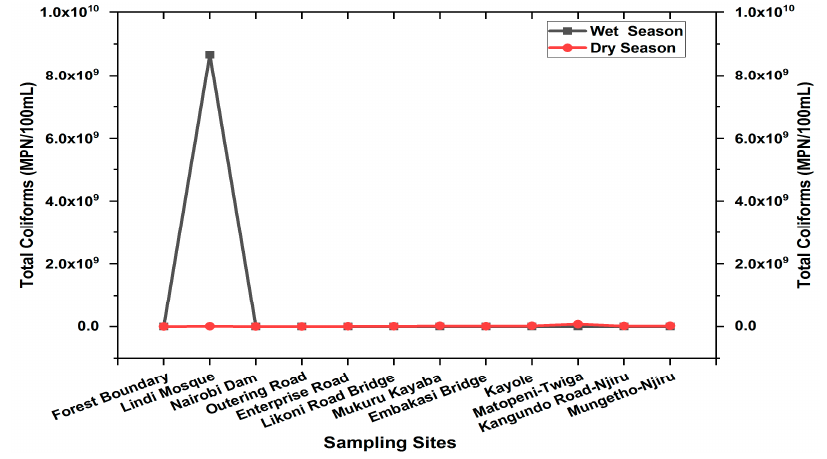
Figure 4. Total coliforms levels in Ngong River measured between April and August 2021.